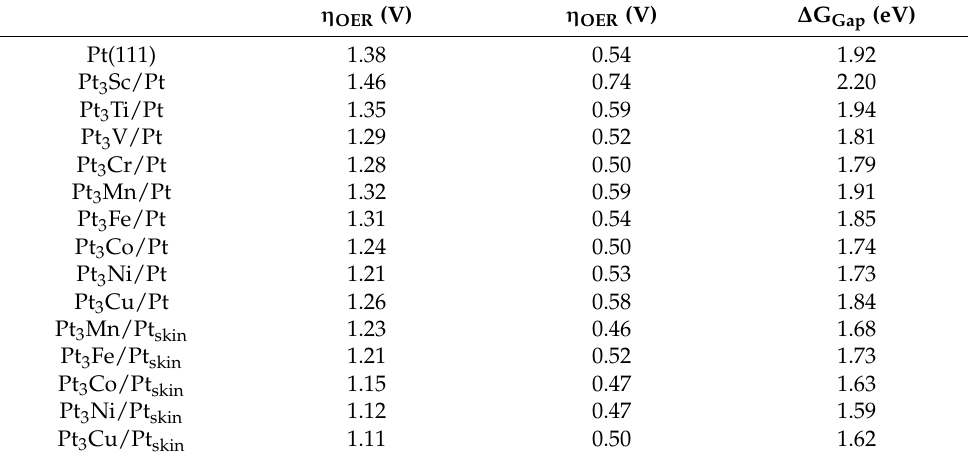
Table 2. Calculated overpotentials for OER and ORR in Pt(111), Pt 3 M/Pt, and Pt 3 M/Pt skin catalysts. ∆ G Gap is the sum of two overpotentials representing activity of OER/ORR bifunctional catalyst. η OER (V) η OER (V) ∆ G Gap (eV)